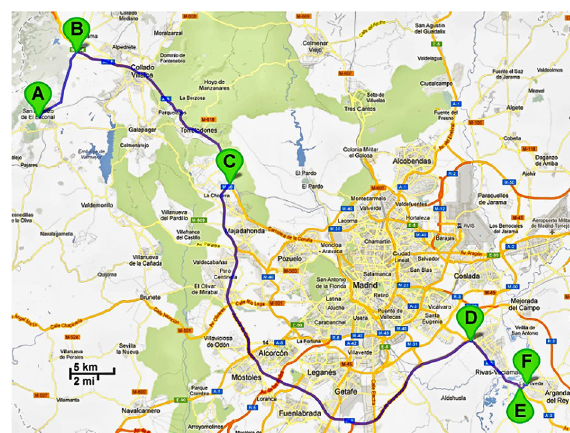
Fig. 8. Route performed by the autonomous vehicles between San Lorenzo de El Escorial and the Centre for Automation and Robotics in Arganda del Rey (image source: Google